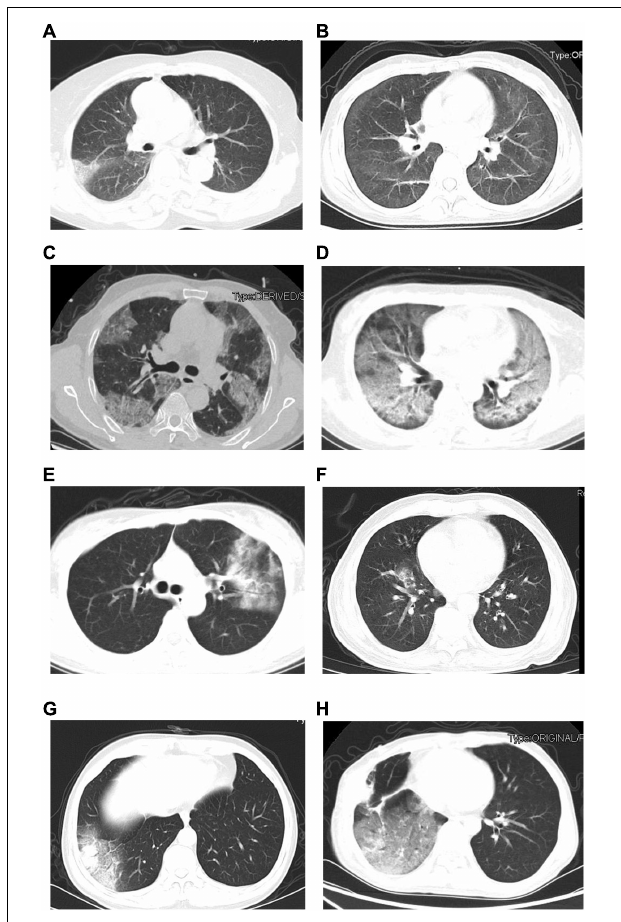
FIGURE 2 | The initial chest CT features of SARS-CoV-2-Negative community acquired pneumonia patients (emergent viruses positive patients: A–D and emergent viruses negative patients: E–H ). (A) Ground-glass opacities in right lung (bacterial pneumonia). (B) Ground-glass opacities, strip shadow, and partial interlobular septal thickening in double lung (AIDS). (C) Ground-glass opacities and nodules were widely distributed in both lungs, Crazy-Paving sign could be seen in some lesions (AIDS). (D) Diffuse distribution of patchy shadows, reticulation and multiple nodules in both lungs (systemic lupus erythematosus, lupus nephritis, and pneumocystis pneumoniae). (E) Ground-glass opacities, reticulation, and consolidation in left lungs ( Chlamydia pneumoniae pneumonia). (F) Ground-glass opacities and consolidation in right lung ( Mycoplasma pneumonia ). (G) Ground-glass opacities and consolidation in right lung (alcoholic cirrhosis and bacterial pneumonia). (H) Chest CT scan shows Ground-glass opacities in right lungs (postoperative lung cancer, immune-associated pneumonia, and presumptive bacterial